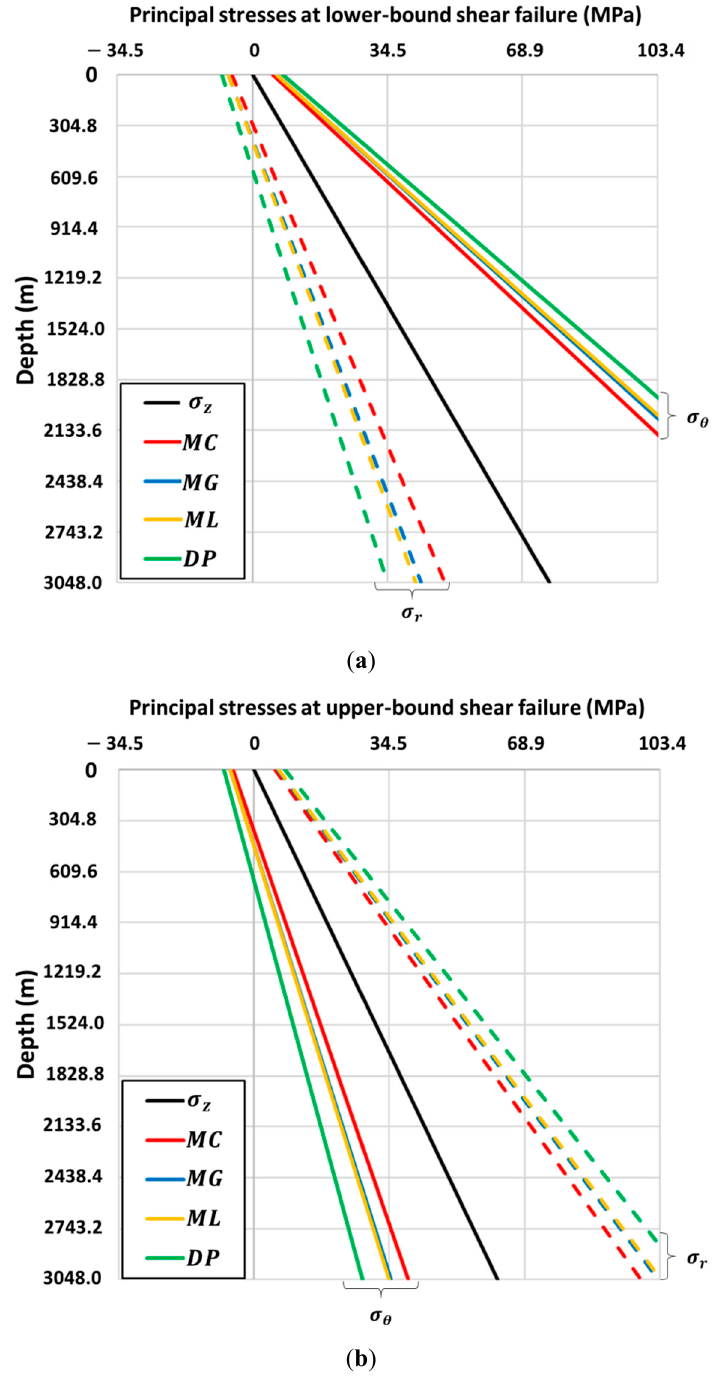
Figure 3. Reverse faulting regime—compressional basin. Locally induced principal stresses at a moment of ( a ) lower-bound and ( b ) upper-bound shear failure under the reverse faulting regime with the vertical, maximum and minimum horizontal stresses of 22.6, 29.4, and 24.9 kPa / m, respectively. The black solid lines represent the axial stress ( σ z ) . The tangential ( σ θ ; solid) and radial ( σ r ; dashed) stresses are calculated by the Mohr–Coulomb (MC; red), Mogi–Coulomb (MG; blue), modified Lade (ML; yellow), and Drucker–Prager (DP; green) failure criteria.